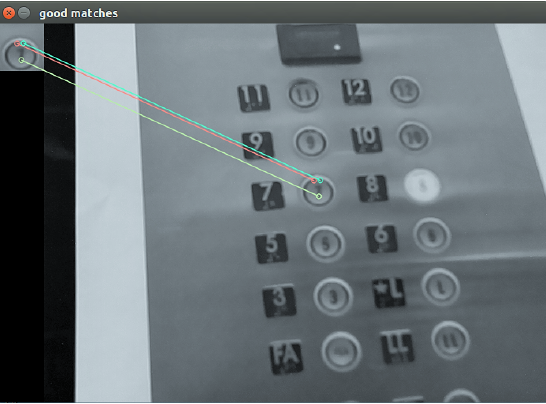
Figure 9. SIFT extracted featuresmatchedto the ROIkeypoints • Scale estimation and 3D re-projection of the